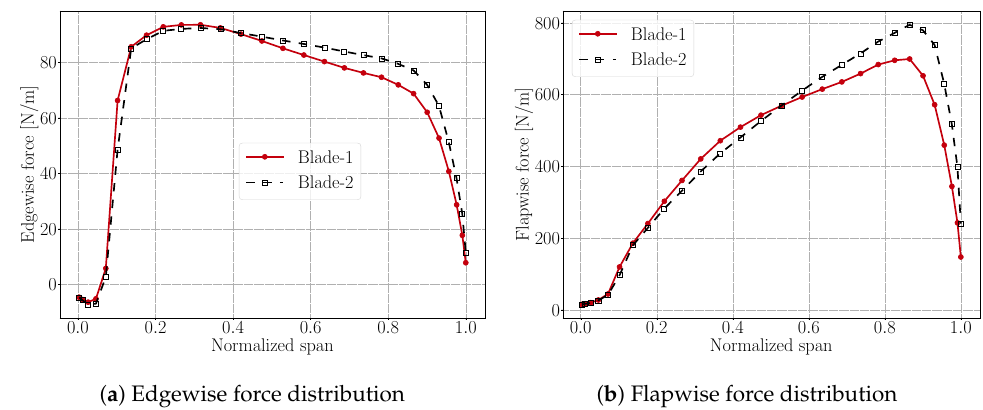
Figure 14. Edgewise ( a ), flapwise ( b ) load per span, lift coefficient, and total wind speed seen by the cross-sections over a normalized span at 10m/s steady wind